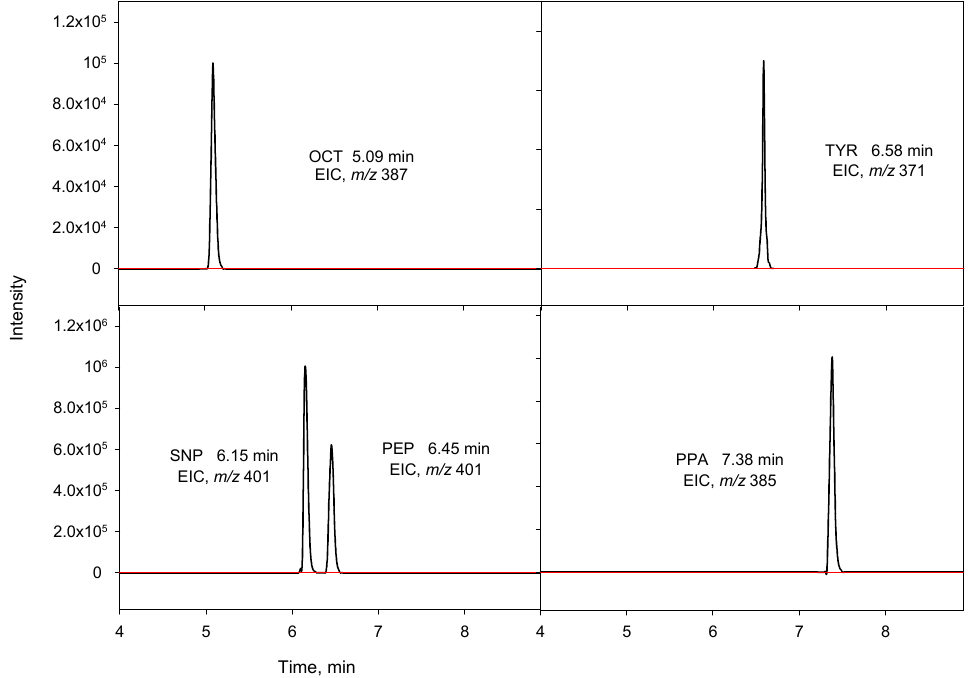
Figure 2. Extracted ion chromatograms (EICs) obtained for a non-spiked urine sample (red line) and a urine sample spiked with the BAs at 80 µg L − 1 (IS, 100 µg L − 1 ) (black line).